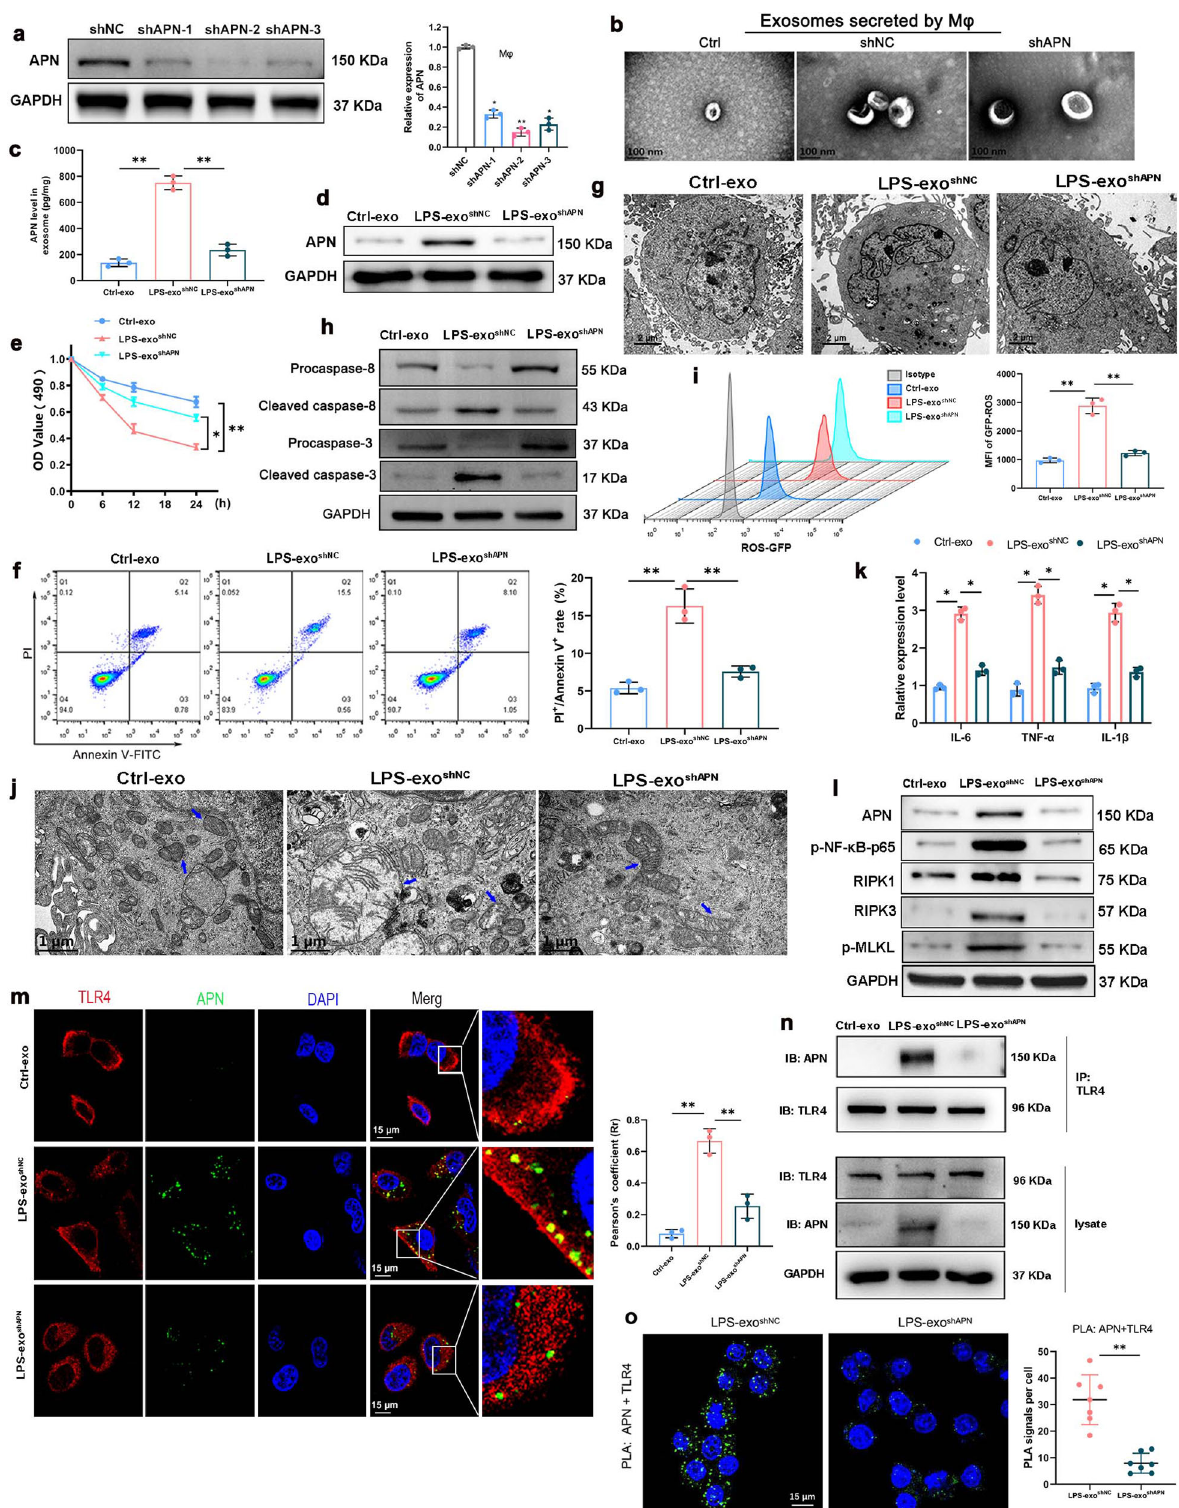
exosomal APN expression in predicting the prognosis of sepsis- induced ALI. Our data showed that the AUC ROC curve for APN was 0.794 (95% CI, 0.649 – 0.939) (Fig. 7d). ROC curves and Youden ’ s index were used to establish the cutoff value. (Youden ’ s index = sensitivity + speci fi city − 1). According to Youden ’ s index, a cutoff of 641.1 pg/mL had the best sensitivity (68.8%) and speci fi city (81.8%) for distinguishing patients with bad results